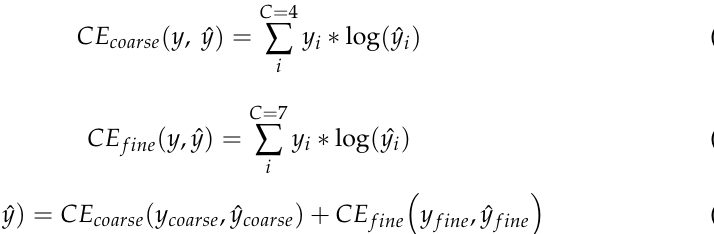
where C is the number of classes; y i is an indicator function, which is one if y i belongs to class i and zero otherwise; and ˆ y i is the predicted probability when the input belongs